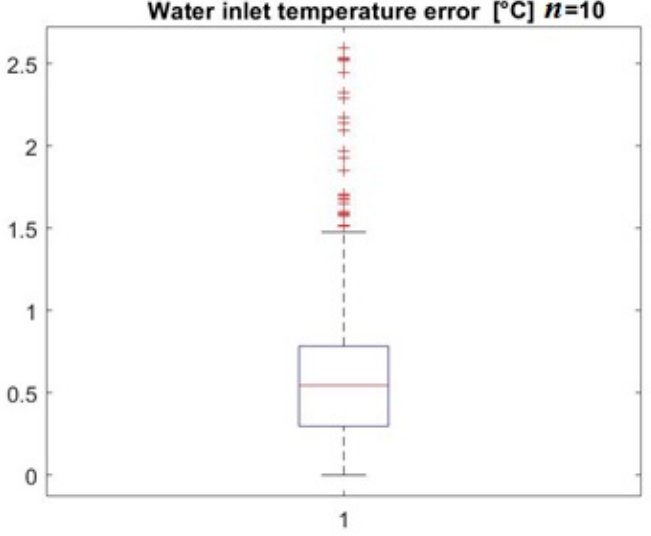
Figure 20. Water inlet temperature error blockplot diagram for a number of sections n = 10.